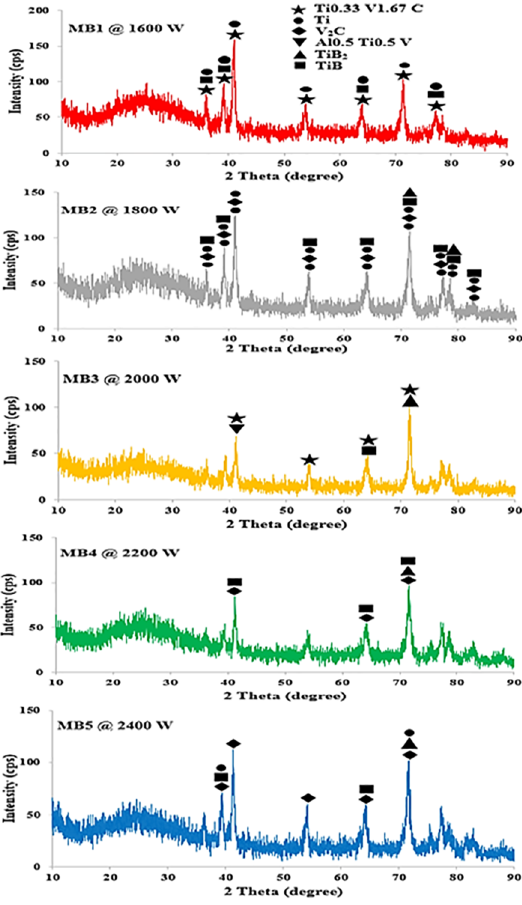
Figure 8. X-ray diffraction (XRD) spectra for the alloyed zone with phase identification.